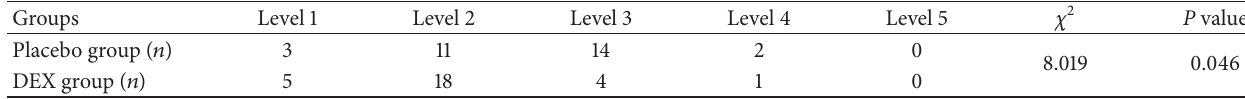
Table 3: Quality of intraoperative surgical field during FESS.